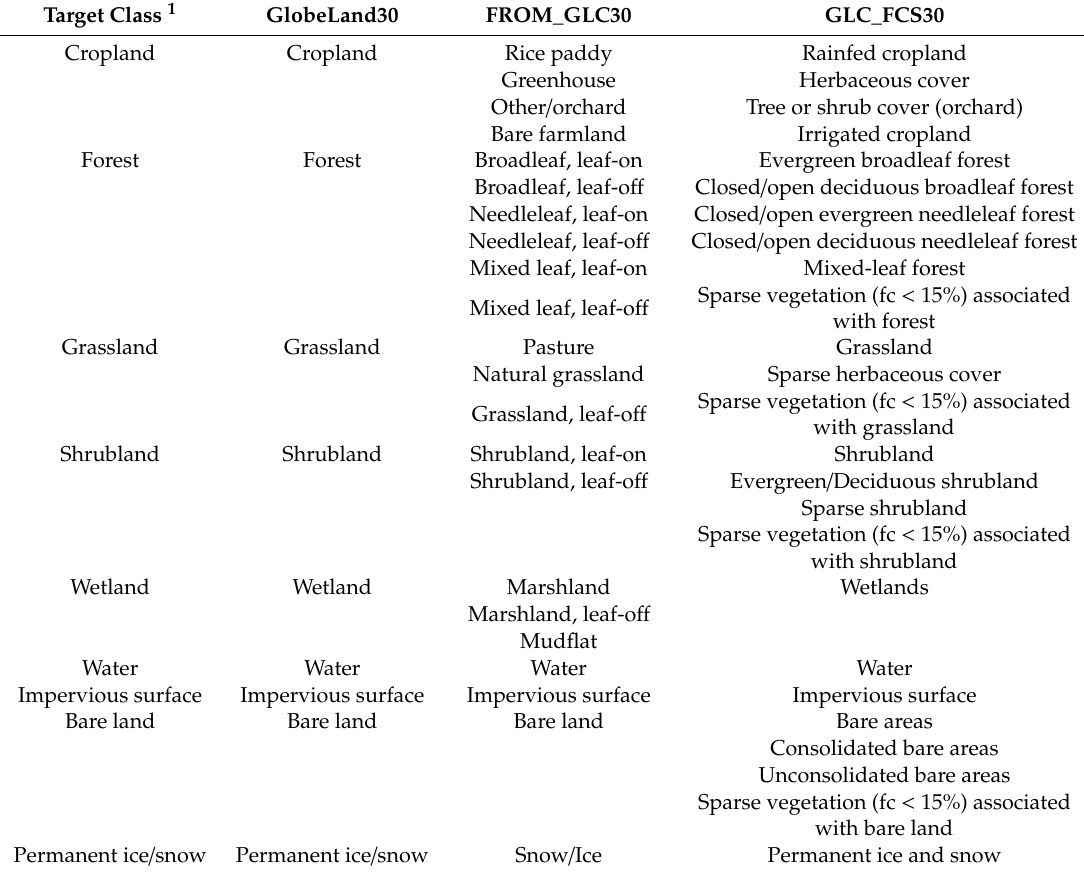
Table 2. Relationship between the target classification system and the classification systems of the di ff erent global land-cover